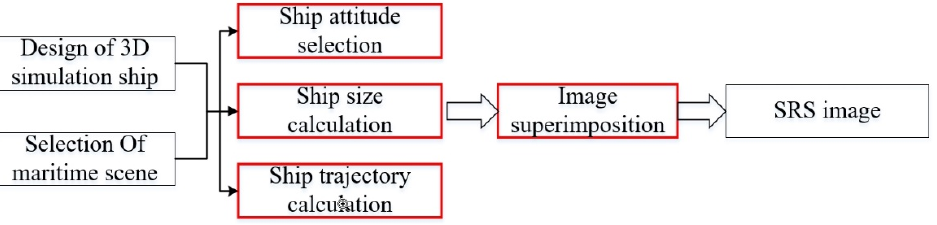
Figure 3. Key steps of SRS images generation.